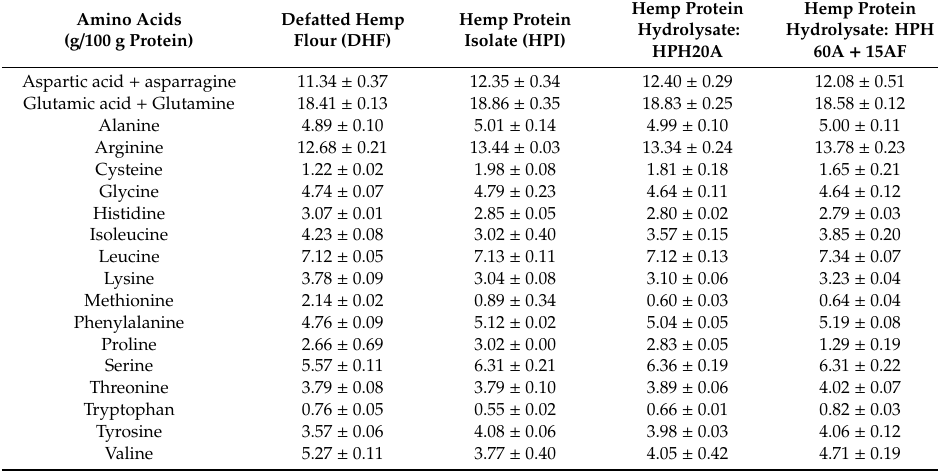
Table A2. Amino acid profile of defatted hemp flour (DHF), HPI, HPH20A and HPH60A15F by HPLC. Values were expressed as a percentage of amino acids on the total amino acid content, are the mean ± standard deviation of triplicates